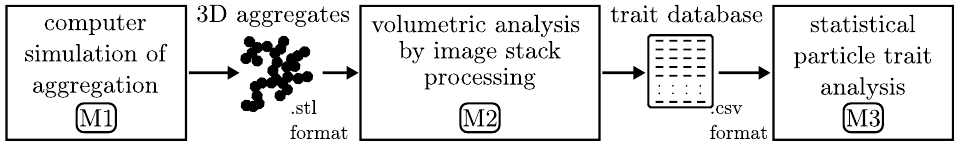
Figure 4. Schematic overview of the pipeline used to compute three dimensional (3D) particle trait distributions (PTDs) based on virtual silicon dioxide (SiO 2 )